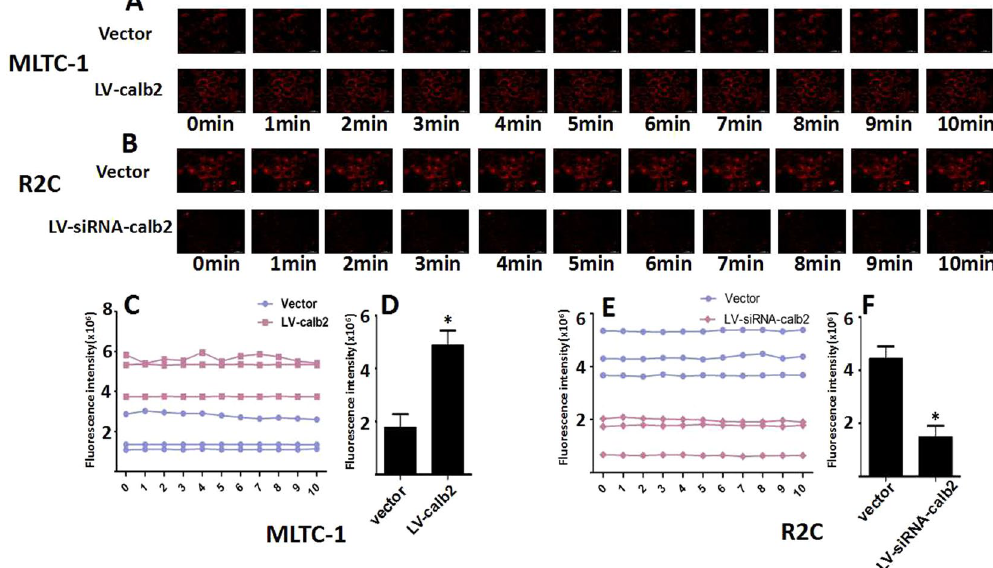
Figure 4. Changes of Cytoplasmic Ca 2 + in the MLTC-1 and R2C cells after LV-calb2 or LV-siRNA-calb2 infection. The Ca 2 + level was measured using X-Rhod-1 Calcium Imaging Kit. Intracellular Ca 2 + was probed using X-Rhod-1 and images were captured every 1 min for 10 min. There was no visible change of signal strength in single cells during the time course, All experiments were repeated for three times. ( A , C ) The change of fluorescence intensity in the MLTC-1 cells infected with LV-calb2 or vector. The basal signal of Ca 2 + in the LV-calb2 infected MLTC-1 cells was significantly stronger ( p < 0.05), but the fluorescence intensity was not differently changed during 10 minutes of time-course. ( B and E ) The change of fluorescence intensity in the R2C cells infected with LV-siRNA-calb2 or vector. The basal signal of Ca 2 + in the LV-siRNA-calb2 infected R2C cells was weaker ( p < 0.05), but the fluorescence intensity was not differently changed during 10 minutes of time-course. ( D and F ) The signal intensities of those cells infected with LV-calb2 or LV-siRNA-calb2 at the time-point of 5 min were respectively compared with their controls. The intensity was significantly increased by the over-expression of calretinin in MLTC-1 cells (D, p < 0.05), while the intensity was decreased by the down- expression of calretinin in R2C cells (F, p < 0.05). * p < 0.05.